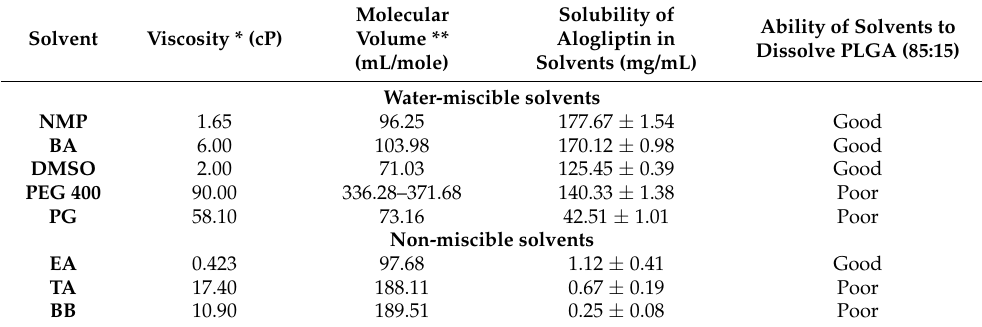
Table 3. Solubility measurements of alogiptin in water-miscible and non-miscible solvents. Solvent Viscosity * (cP)